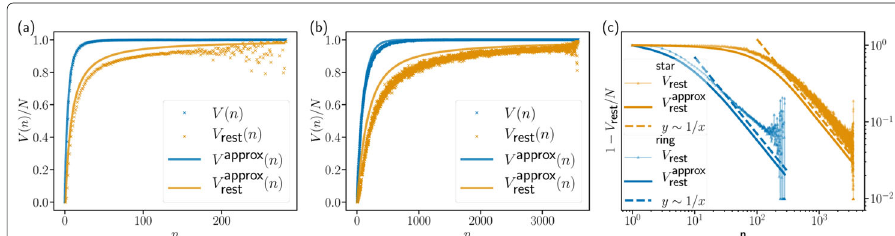
Fig. 2 Volume with stop-list length. a ring graph together with its approximation from Eq. 9 and b star graph together with its approximation from Eq. 10. The analytical approximation for V rest from Eq. 6 slightly overestimates the drop-off volume, indicating that the insertions of the pick-ups are not uniformly random across the whole length of the route. c V rest approaches N indeed as 1 / n in the asymptotic limit, as predicted in Eq. (7)